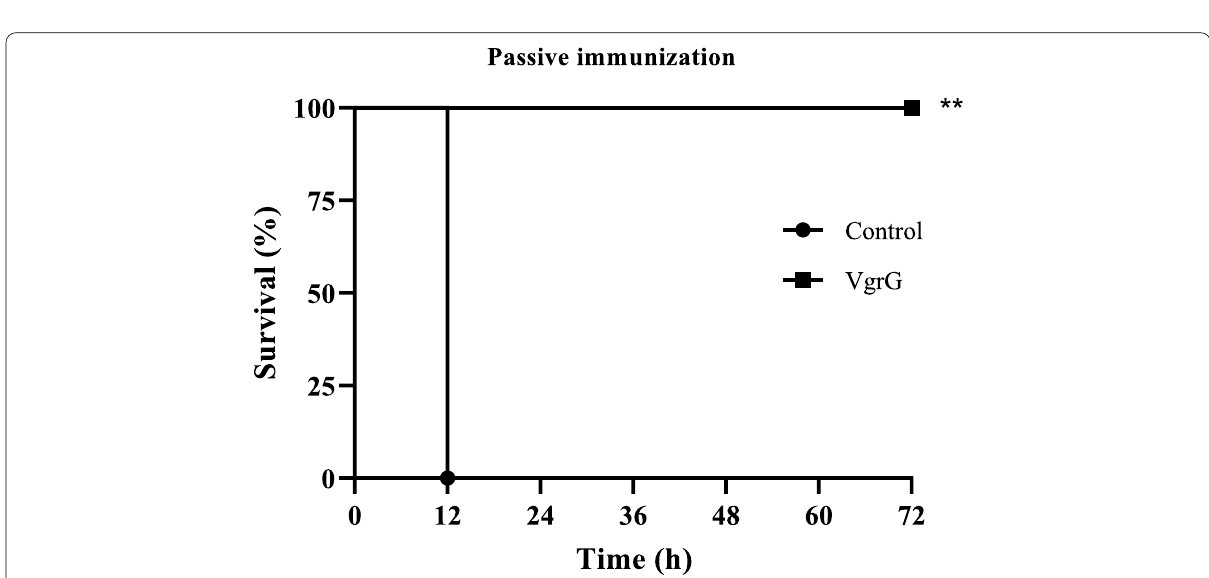
Fig. 4 The mouse survival rate in passive immunization. The non-parametric log-rank test was used for the analyses of survival rates ( p < 0.001)